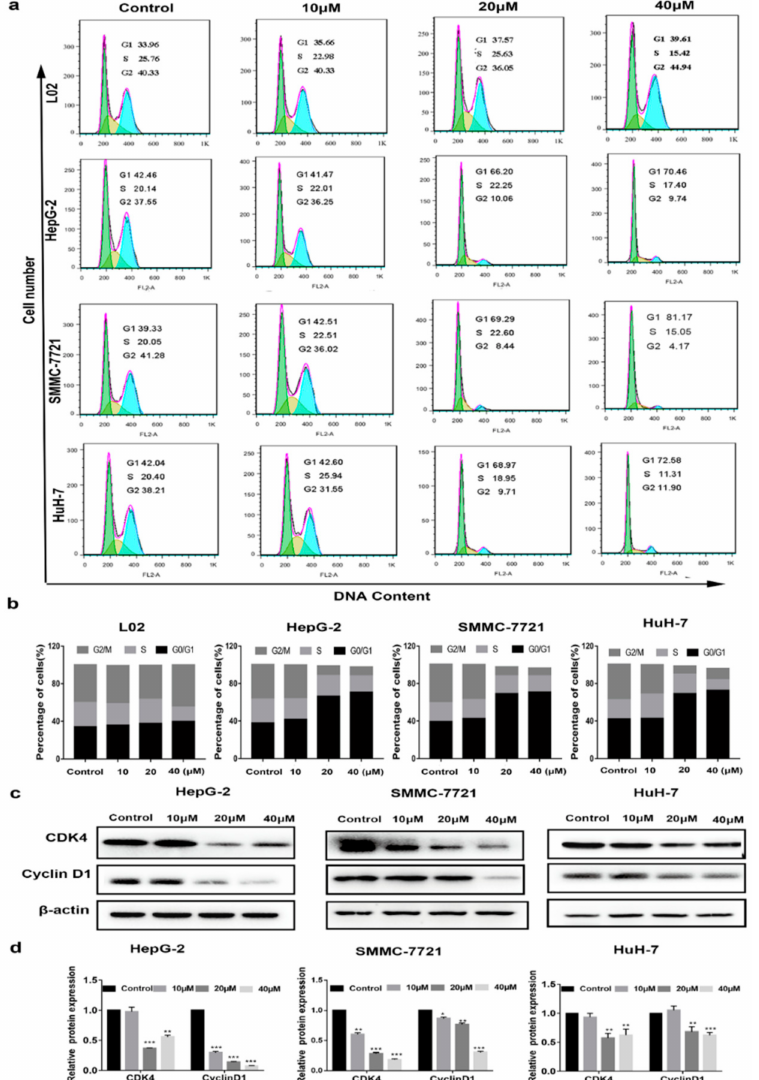
Figure 2. The cell cycle arrest in HCC cells and L02 incubated with compound 1 . ( a , b ) The cell cycle phases of the treated cells were evaluated by flow cytometry. The x-axis represents periodic distribution and the y-axis represents the number of cells. ( c , d ) The protein levels of cell cycle regulators, CDK4 and cyclinD1, were examined by Western blot analysis. * p < 0.05, ** p < 0.01, and *** p < 0.001 compared with the